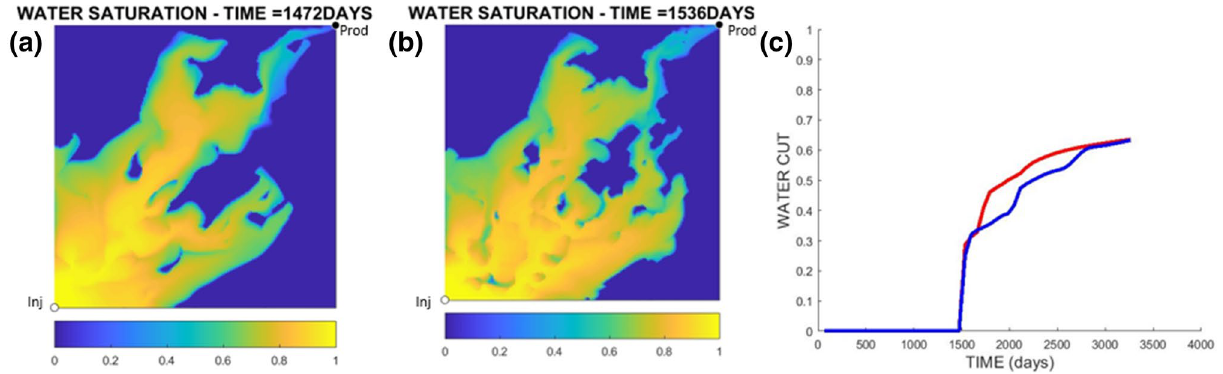
Fig. 9 a Saturation map for DM1 model at breakthrough. b Saturation map for DM2 model at breakthrough. c Water cuts simulated for DM1 (red) and DM2 (blue)